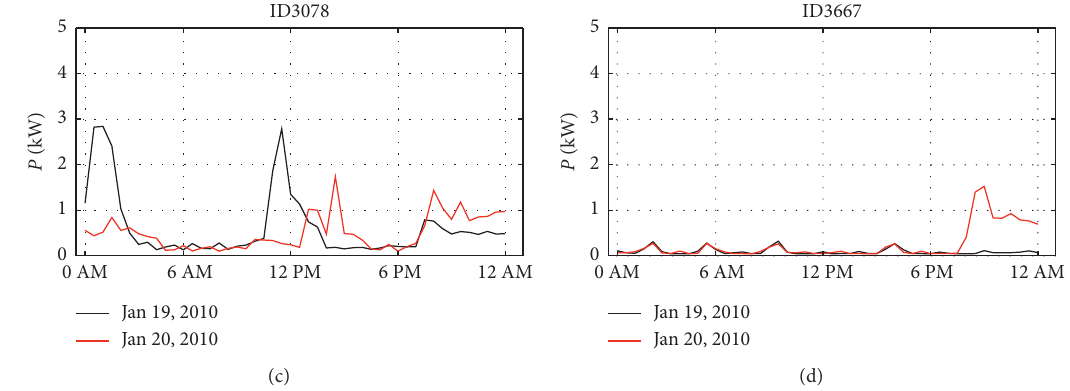
Figure 3: Power consumption of four residential loads in two consecutive working